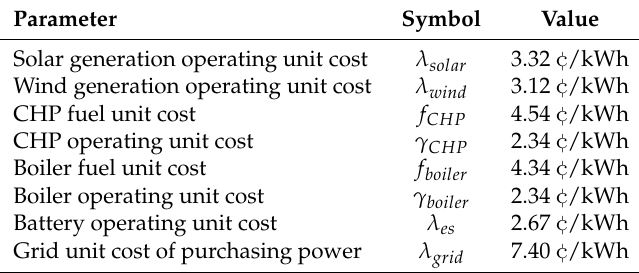
Table 3. Unit costs of energy systems